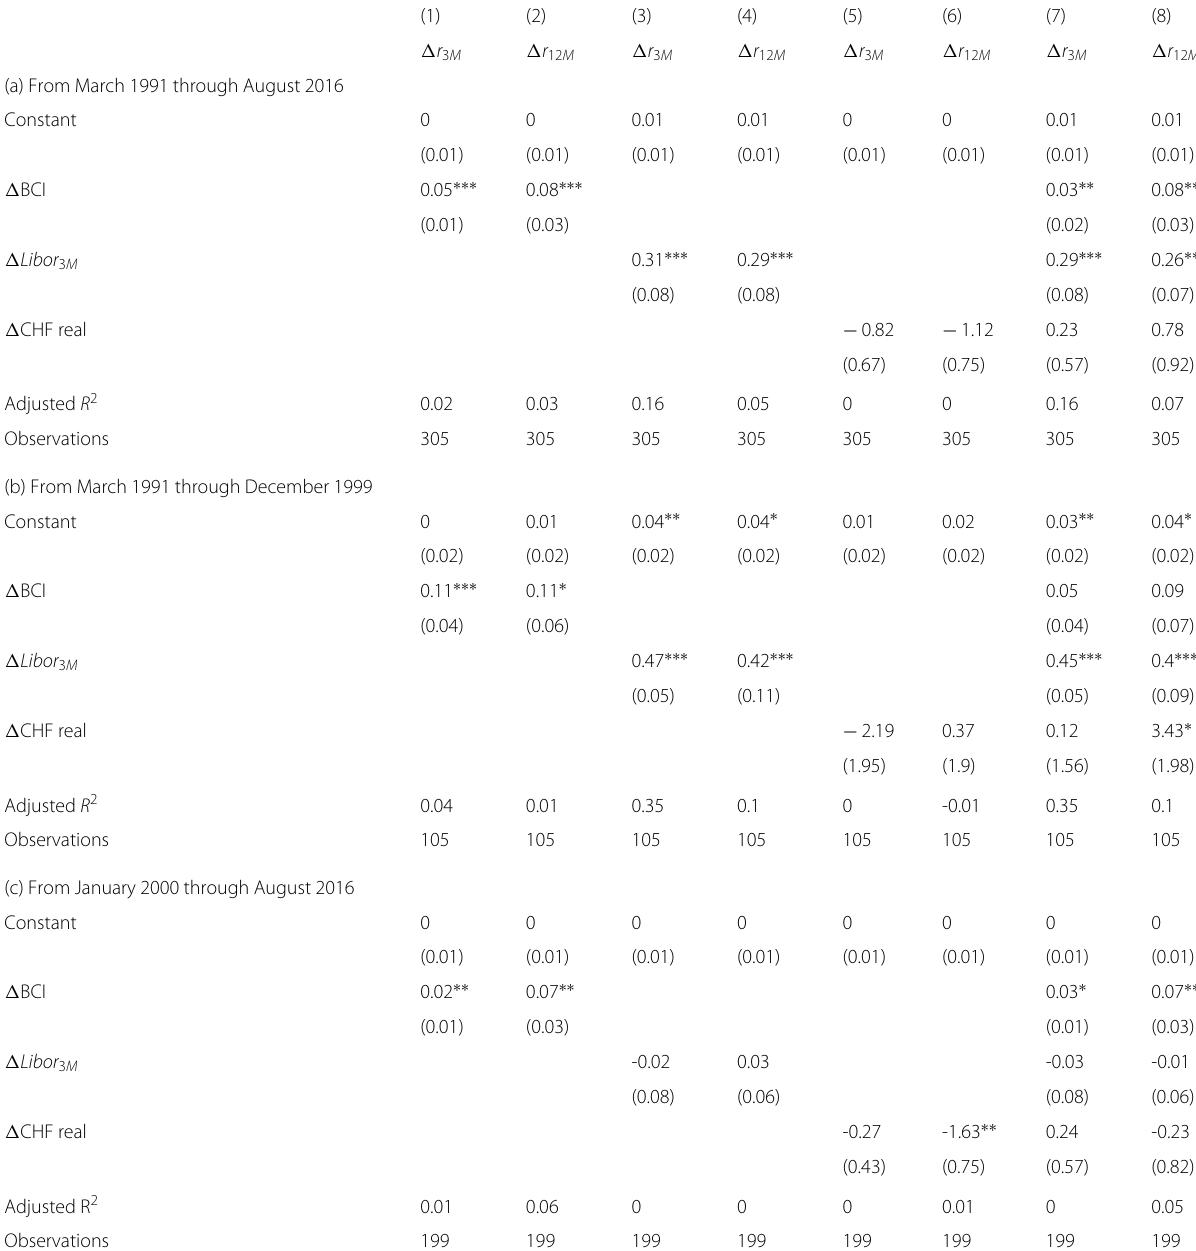
Table 7 Economic variables and the term